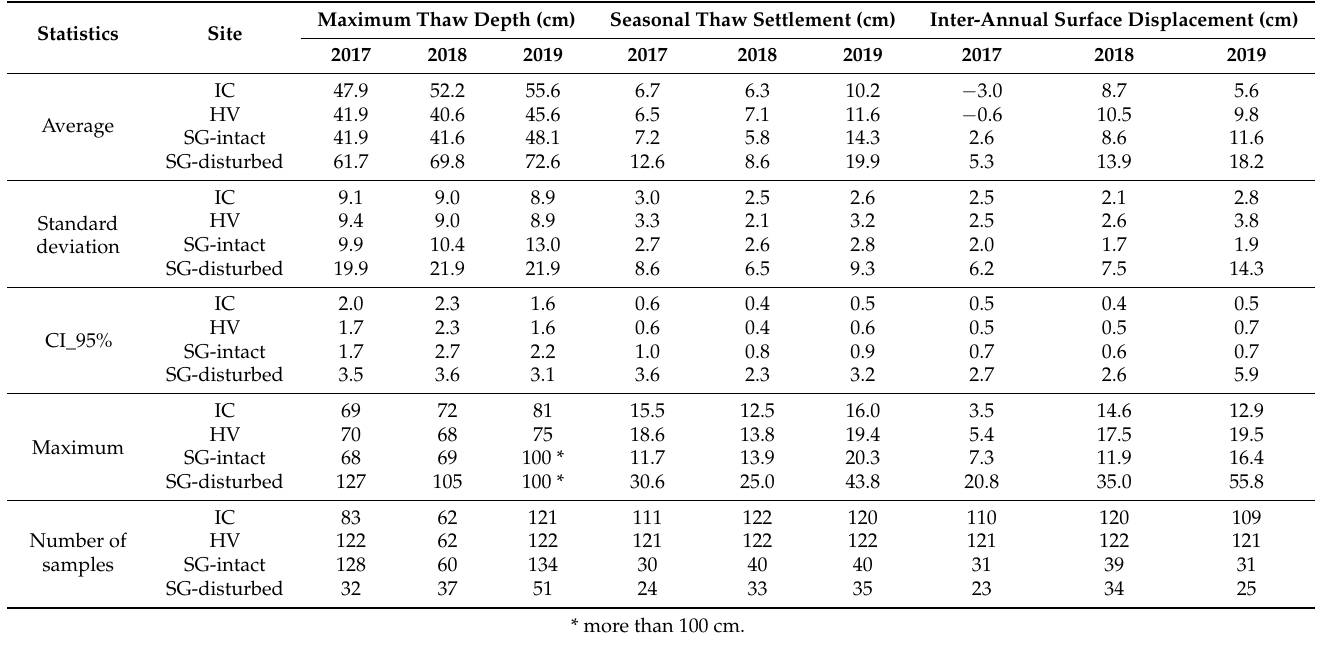
Table 2. Maximum thaw depth, seasonal thaw settlement, and interannual surface displacement at study sites in 2017, 2018, and 2019.